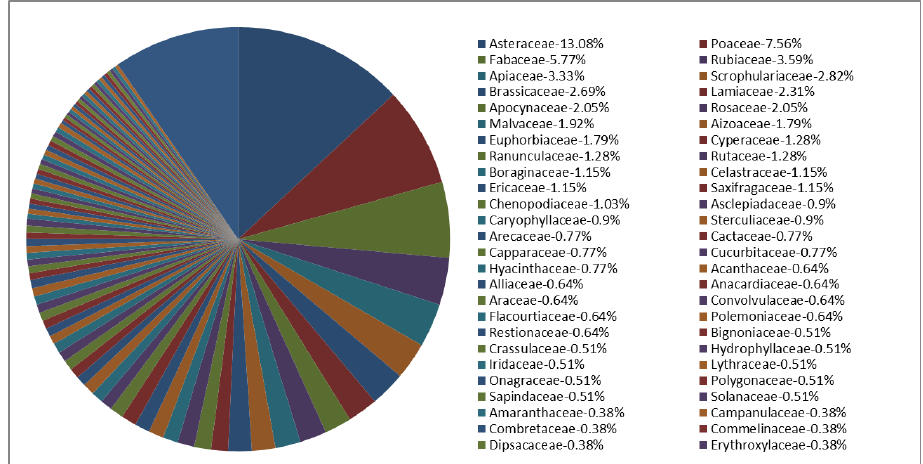
Figure 4. Families of the plants and respective percentage of use in this study.